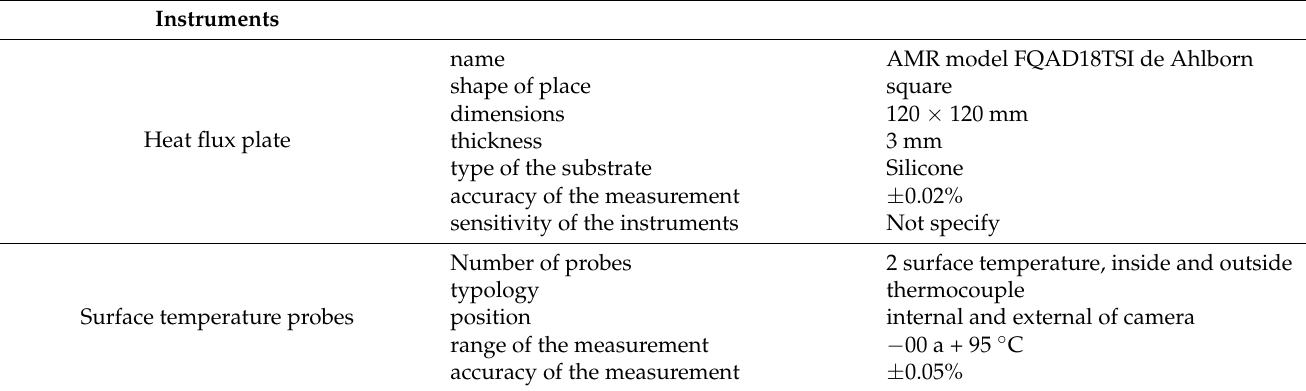
Figure 3. Above left, elevation of the cold chamber. Top right, floor plan. Bottom left, photograph. Bottom right, vertical section. Table 1. Characteristics of HFM apparatus